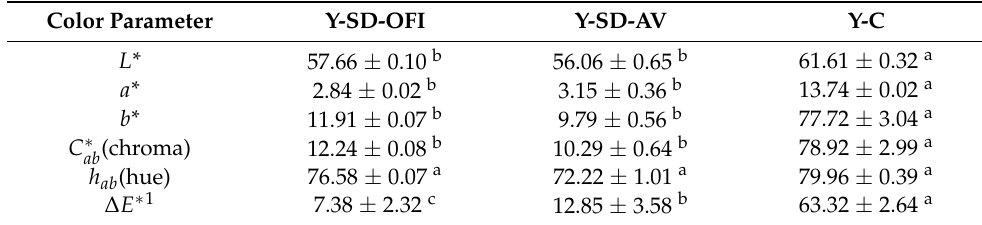
Table 2. Color parameters and color stability ( ∆ E ∗ ) data for yogurt samples enriched with pulp- Different superscript letters in the same row and column for each parameter indicate a statistical difference ( p < 0.05) between